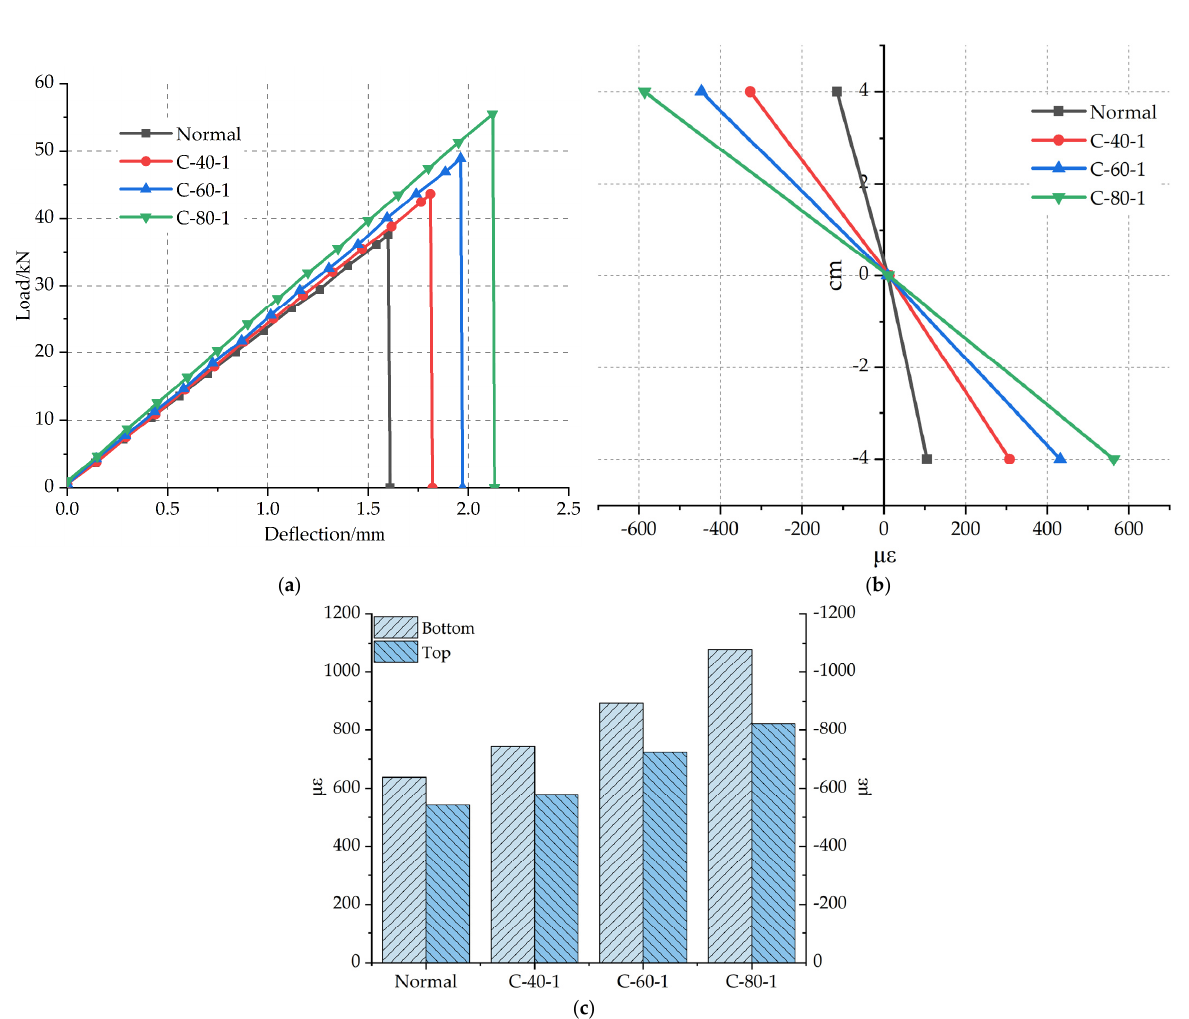
Figure 14. ( a ) Load–deflection curves of different grid widths. ( b ) Failure strain along the beam height for different grid widths. ( c ) Failure strain at the bottom and top of beams with different grid widths.